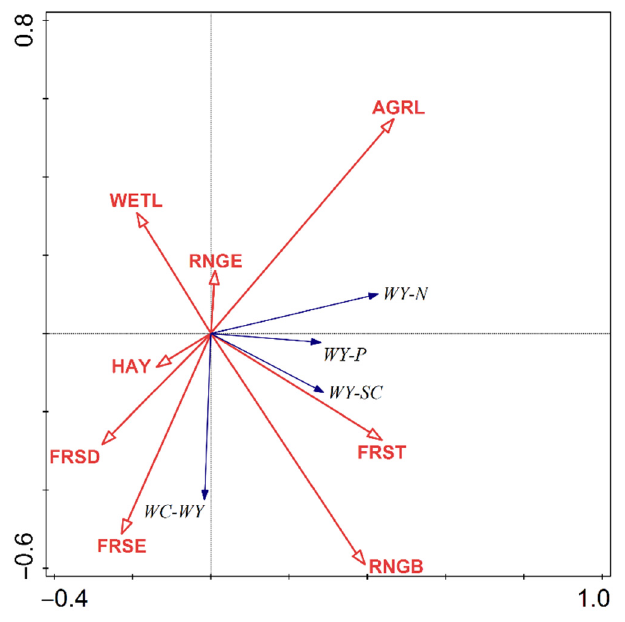
Figure 11. Biplot diagram of the RDA between various tradeoffs and environmental factors.